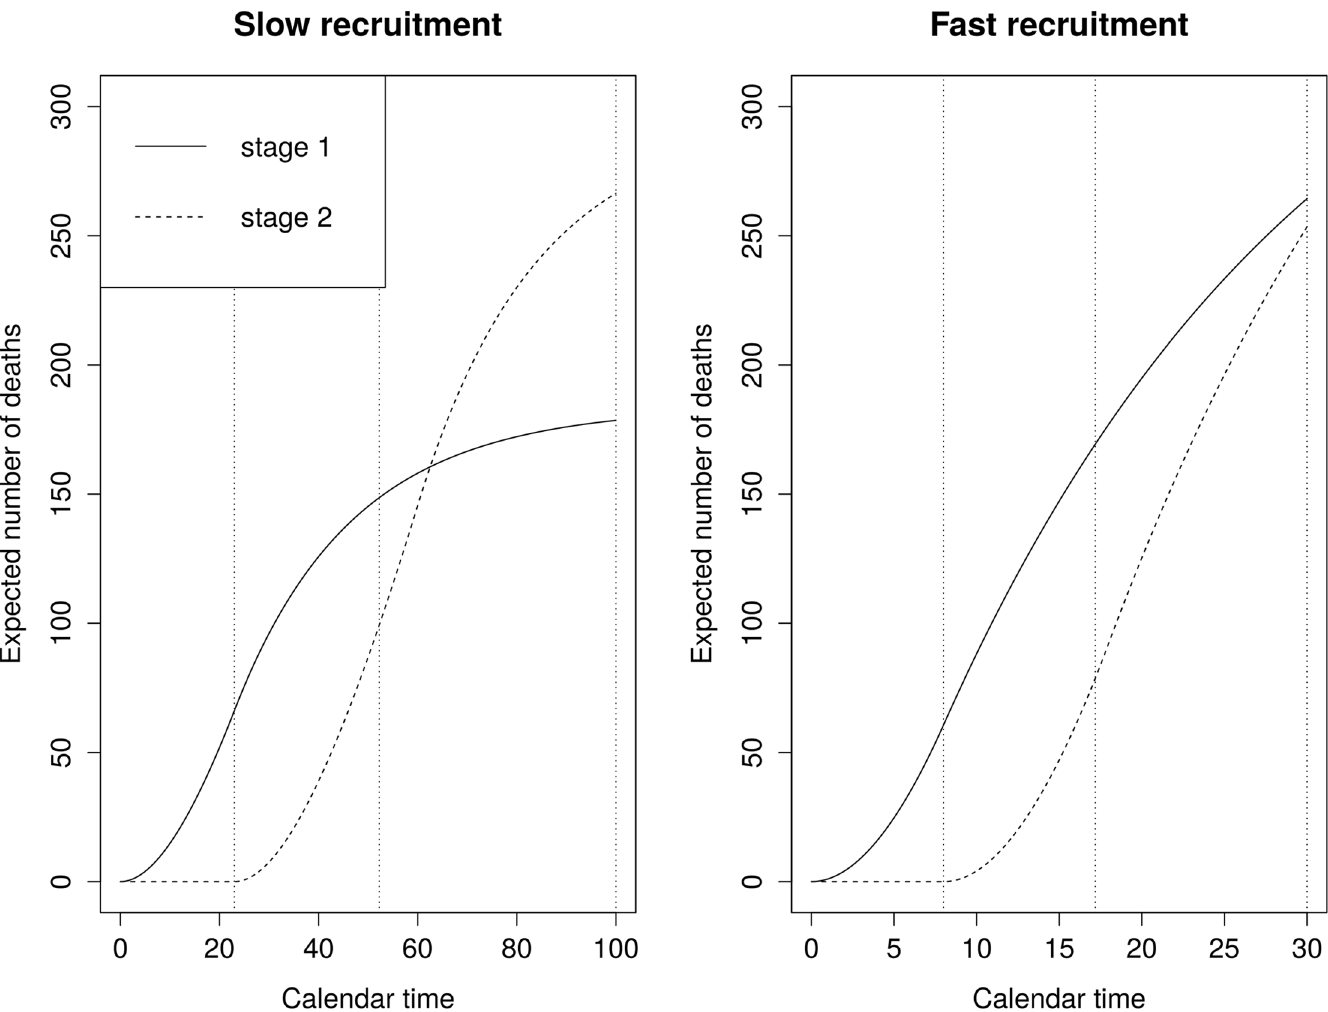
Fig 3. Expected total number of events as a function of time based on exponential survival with hazard rates λ C = 0.05 and λ E = 0.035. Slow recruitment: 8 patients per month for a maximum of 60 months. Fast recruitment: 50 patients per month for a maximum of 18 months. Vertical lines are at T int , T end and T max